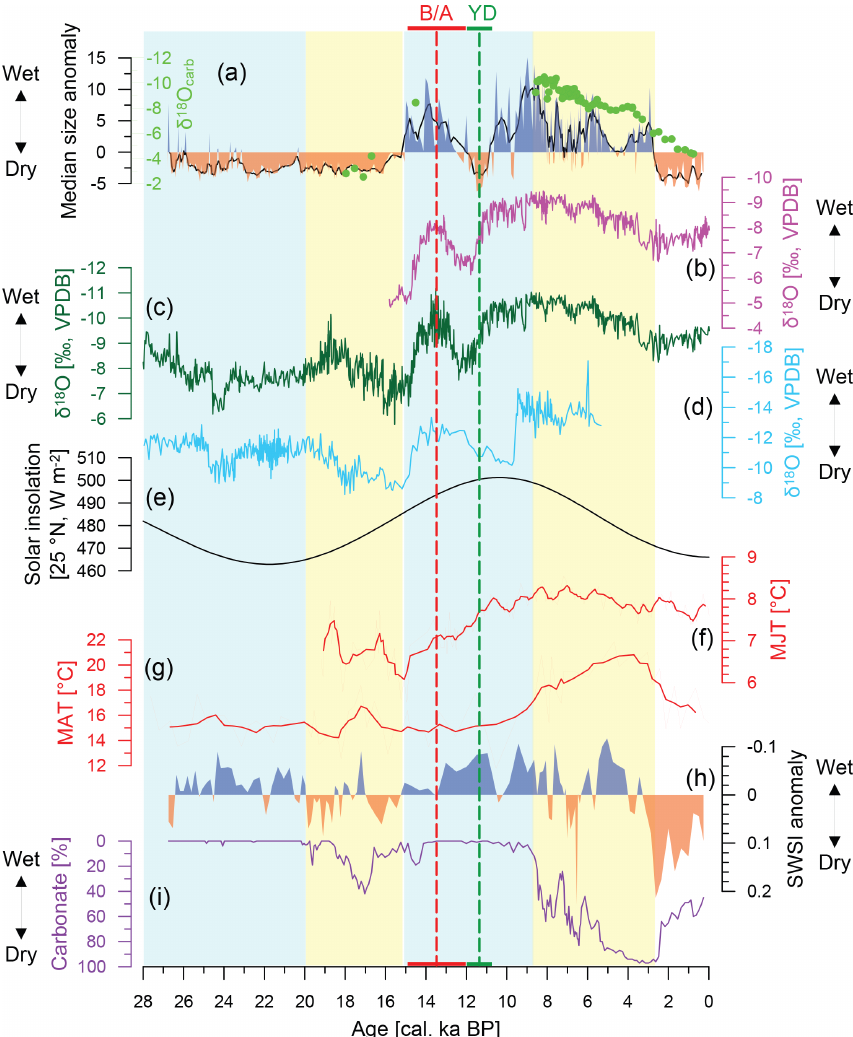
Figure 5. Median size and δ 18 O carb values from Yilong Lake (a) ; stalagmite δ 18 O records from Sanbao Cave (Cheng et al., 2016) (b) , Dongge Cave (Dykoski et al., 2005) (c) and Xiaobailong Cave (Cai et al., 2015) (d) ; summer insolation curve for 25 ◦ N (e) ; chironomid- mean July temperature (MJT) from Tiancai Lake (E. Zhang et al., 2019) (f) ; brGDGT-derived mean annual temperature (MAT) from Qionghai Lake (Wang et al., 2020) (g) ; pollen-based reconstructed soil water stress index (SWSI) for Yilong region (h) ; carbonate content of sediments from Yilong Lake (i) . Light yellow (blue) shadows denote periods of inconsistency (consistency) of dry–wet conditions among precipitation, SWSI and hydrological